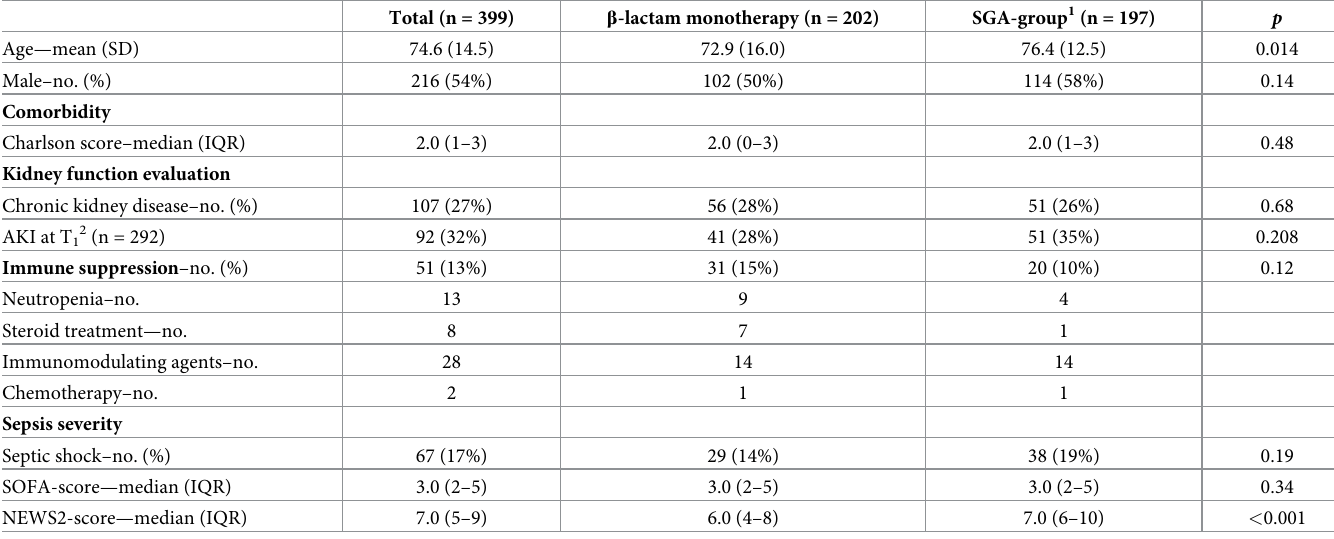
Table 1. Baseline